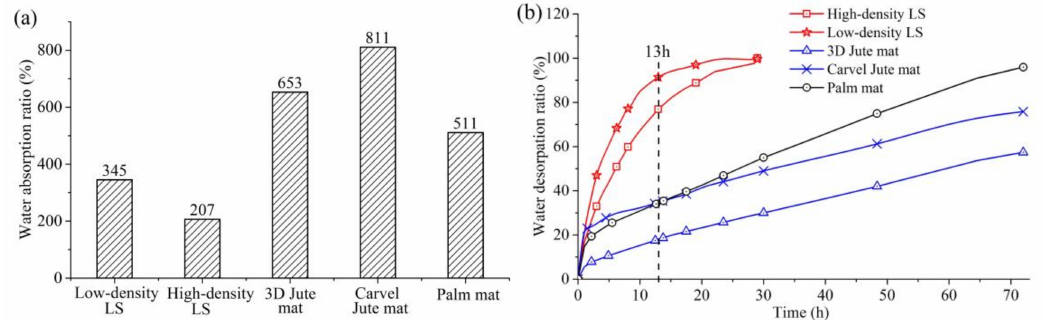
Figure 8. (a) Water absorption of five types of plant mattress filling materials, (b) water desorption of five types of plant mattress filling materials.